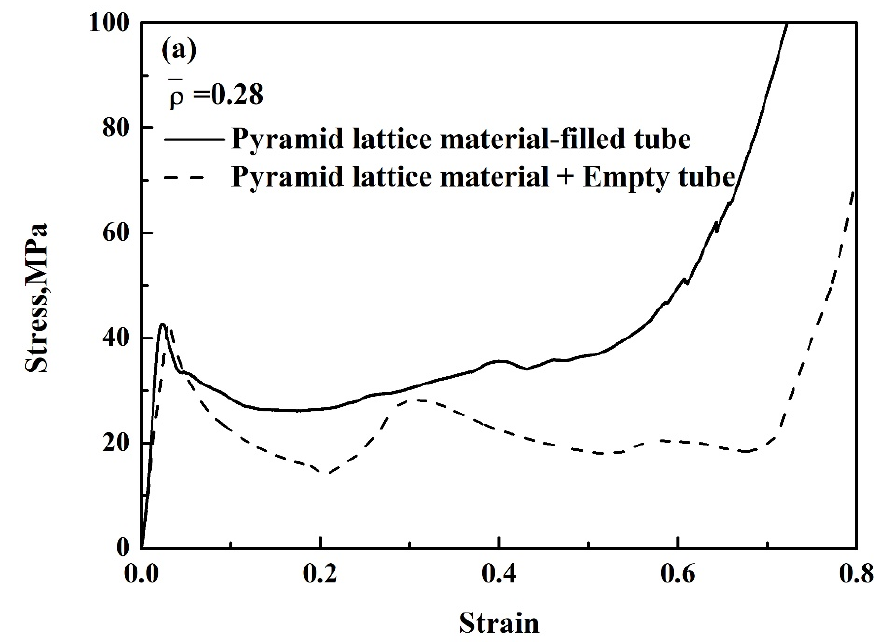
Figure 6. Peak stress of the pyramid lattice material and pyramid lattice material-filled tube with different relative densities.